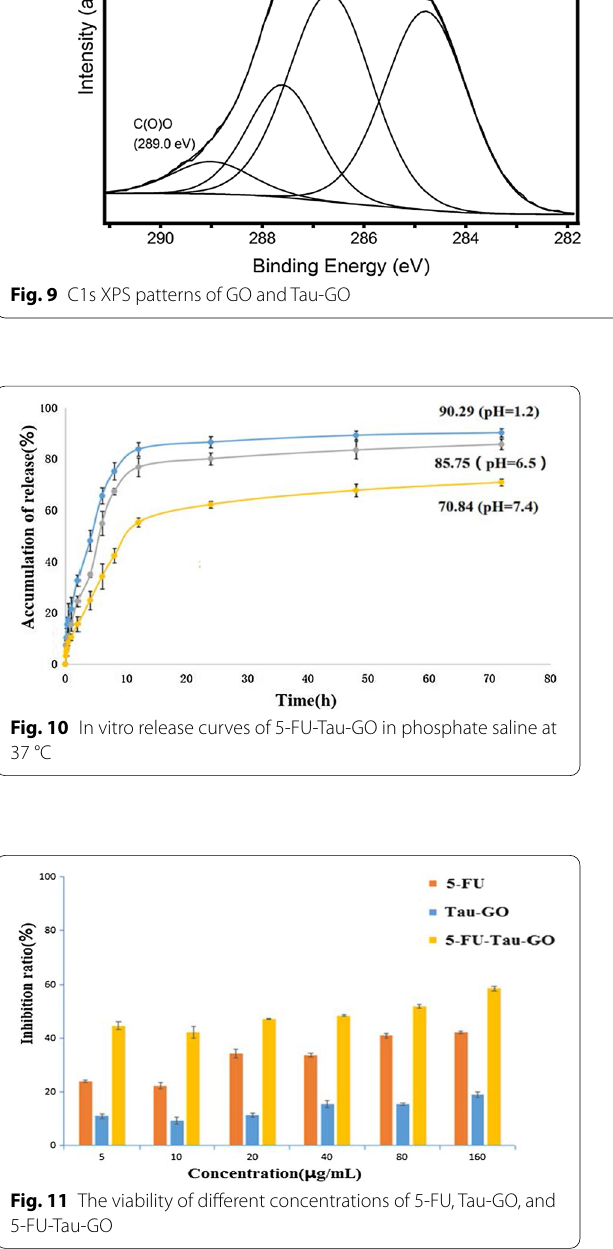
whether the cells death was associated with apoptosis using characteristics of cell morphological changes. The results obtained from the AO/EB staining are presented